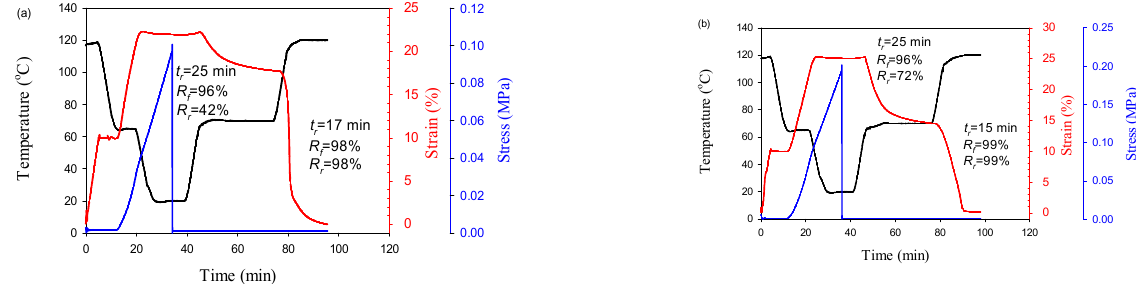
Figure 7. Temperature and strain of PLA/PBAT/CNFs blends ( a ) and in situ generated composites ( b ) during triple shape memory cycle. T d = 65 °C, 120 °C. CNFs—7 wt.%.